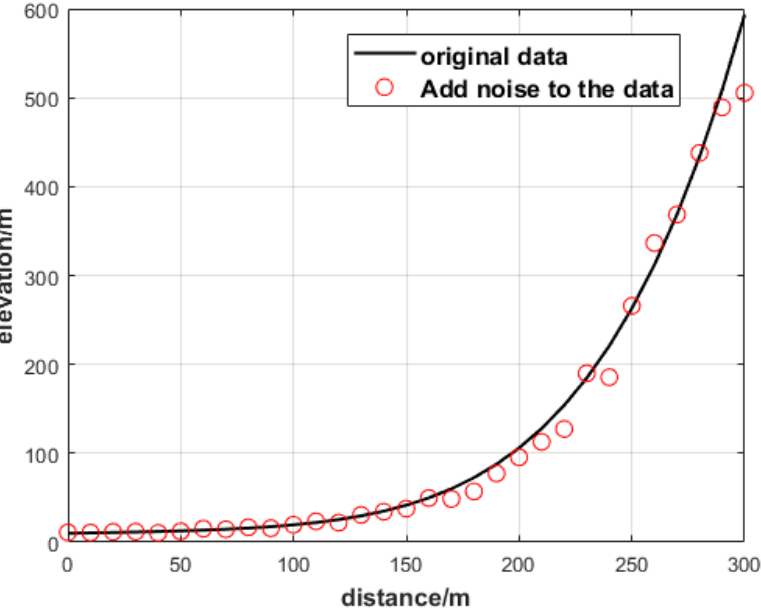
Figure 3. GNSS elevation point before and after being disturbed by multiplicative error.